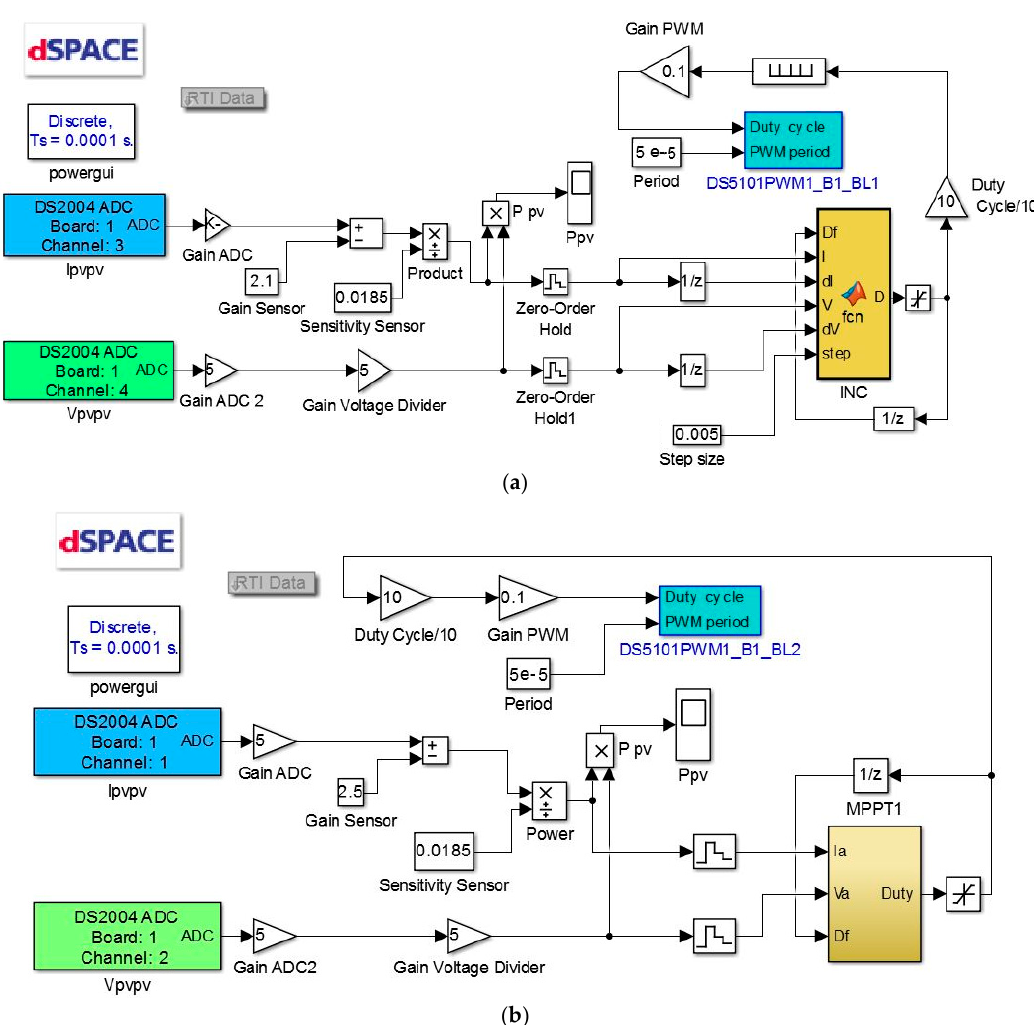
Figure 6. Real time implementation of ( a ) IC and ( b ) P&O MPPT methods in dSPACE.